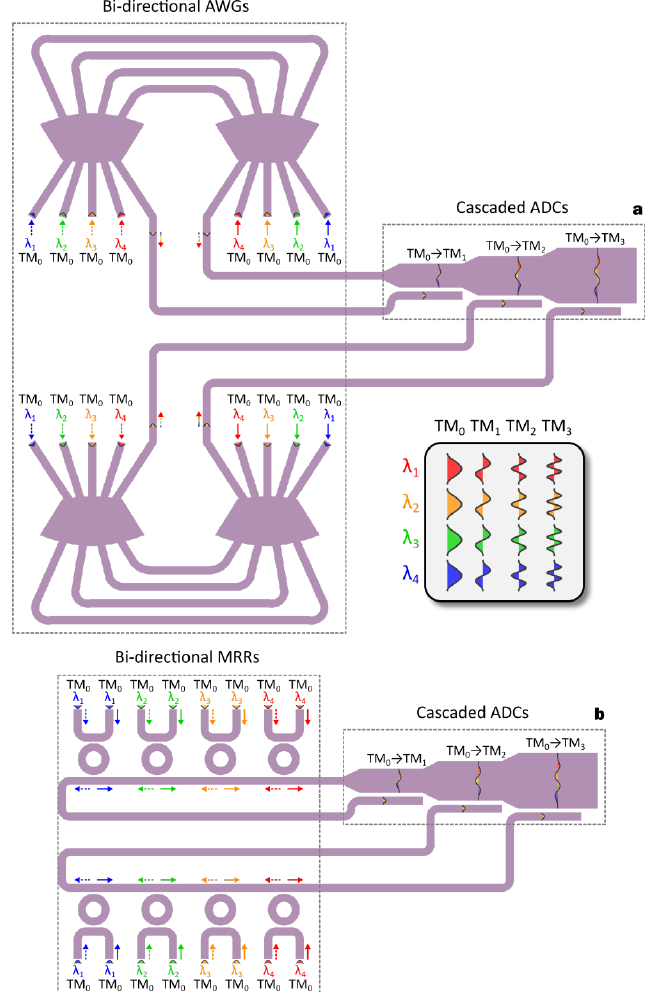
Figure 6. The schematics for the silicon wavelength/mode hybrid (de)multiplexers with ( a ) bi-directional arrayed waveguide gratings (AWGs) [92] and ( b ) bi-directional micro-ring resonators (MRRs) [94]. The inset shows the wavelength and mode channel arrangement. Here, a 4 × 4 wavelength-division multiplexing (WDM)/MDM system is illustrated as an example. Table 2. Summary of the reported silicon wavelength/mode hybrid (de)multiplexers.